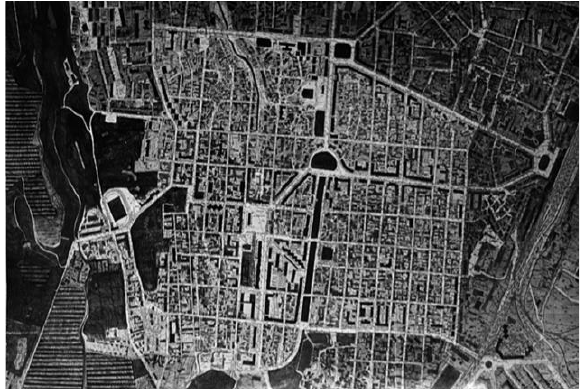
Figure 10. City plan highlighting the grounds of Kumayri Museum Preserve, 1980s. Source: personal files of Sashur Kalashyan, founder of the museum.